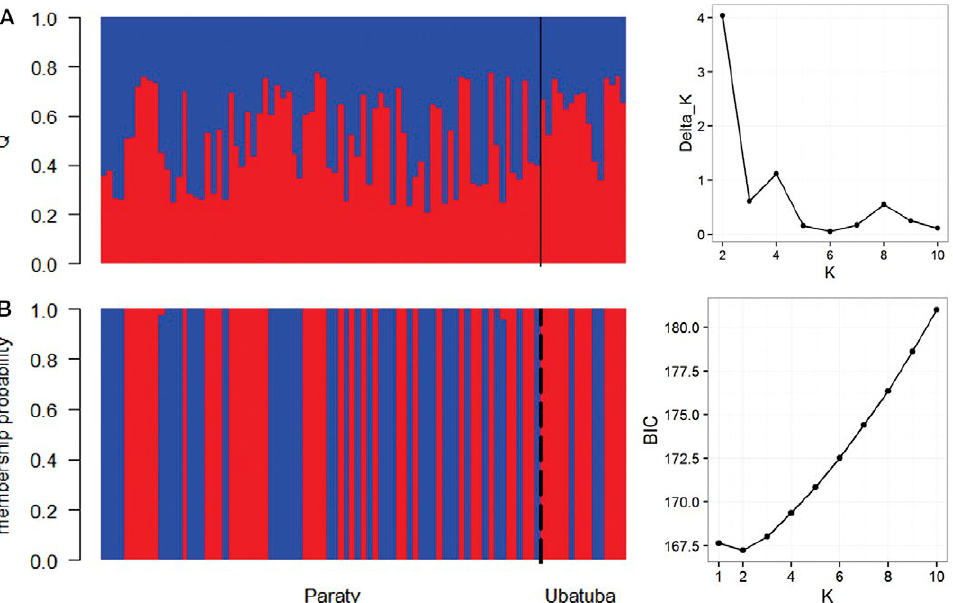
Fig. 2. – A, results of a Bayesian analysis (STRUCTURE) of samples of C. undecimalis and estimates of the number of K groups based on the Delta K statistic of Evanno et al. (2005); B, results of a DAPC analysis and the number of clusters as a function of the BIC values. Both results were based on the analysis of 91 individual C. undecimalis using 15 SSR loci from the Paraty (RJ) and Ubatuba (SP) regions, as indicated on the x-axis. Each column represents a different individual, and the colours represent the probability coefficient of each individual for each genetic cluster: Cluster 1 (red) and Cluster 2 (blue).